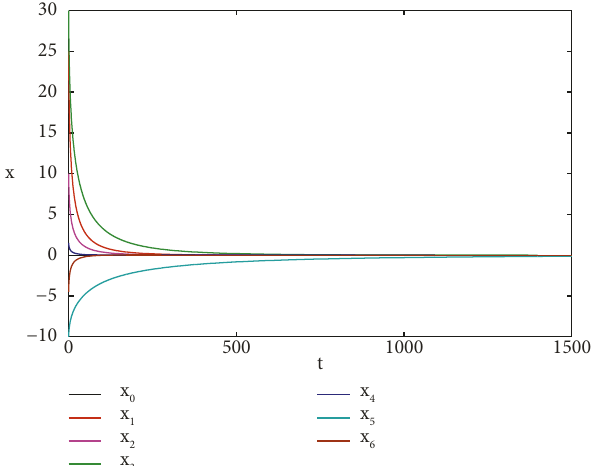
Figure 1: The states of the system of opinion formation model (47) with α � 0 . 5.